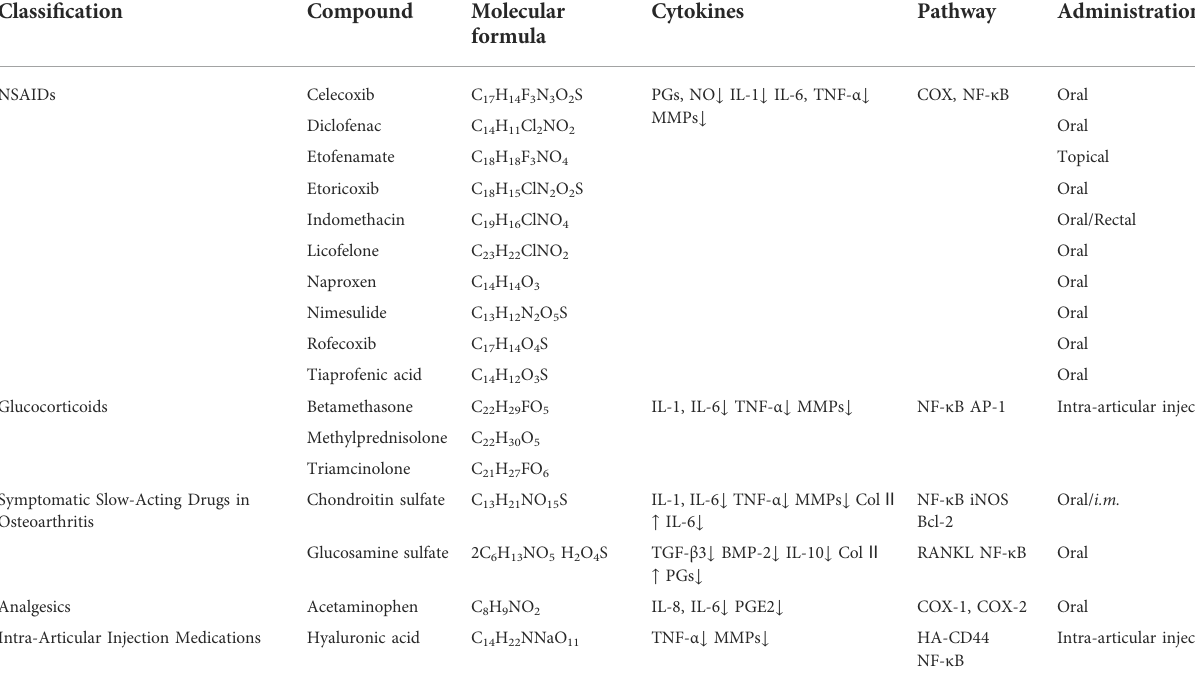
TABLE 1 The in fl uence of chemical drugs in cytokine secretion and the underlying molecular mechanisms in